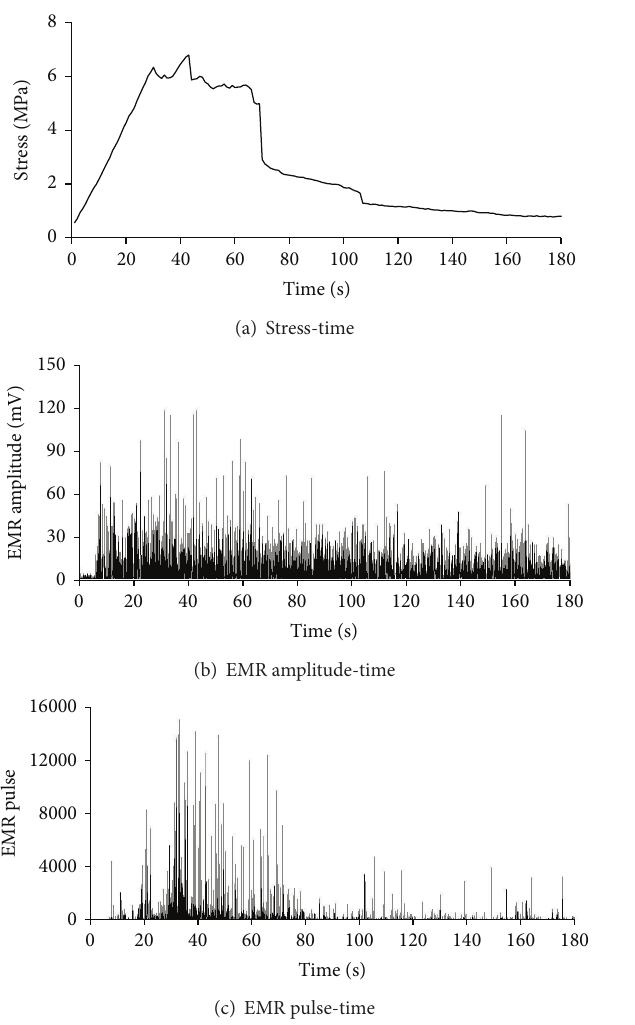
Figure 5: The measured stress and EMR of LM3# coal sample. 132 mV, respectively, when the failure occurs. The average (avg ( ∑ max 𝐸 ) = 118.5 mV) is calculated and obtained, to